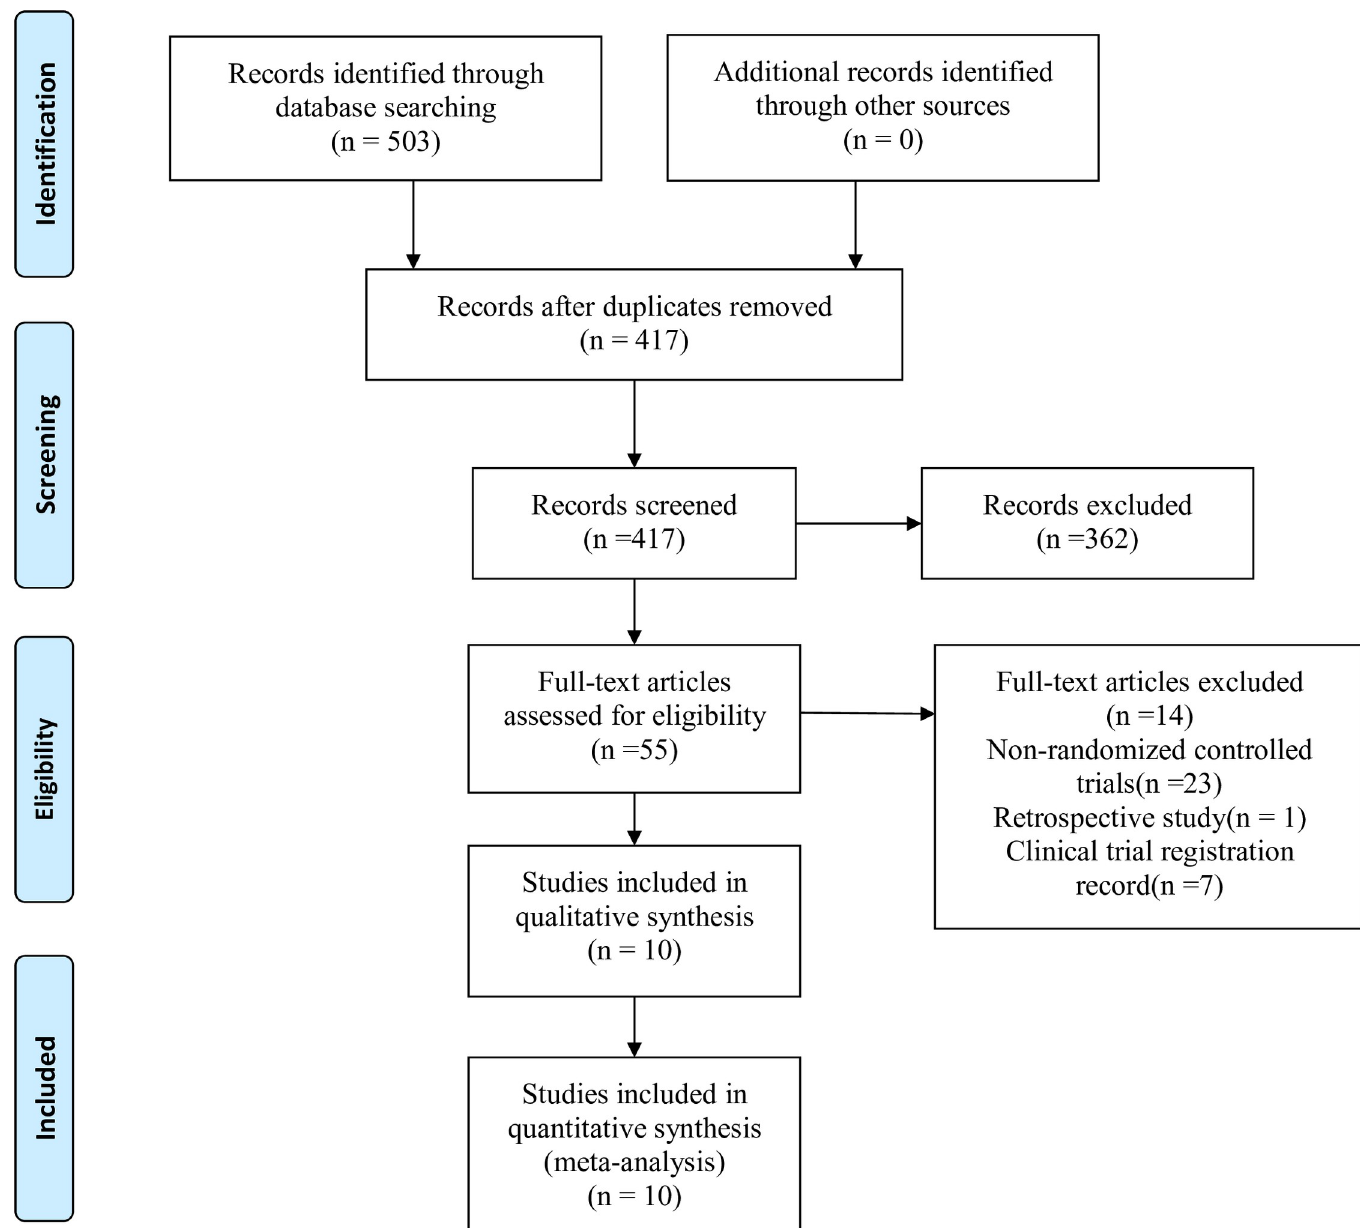
Fig 1. PRISMA flow diagram summarizing retrieved, included, and excluded RCTs. PRISMA indicates Preferred Reporting Items for Systematic Reviews and Meta- Analyses.